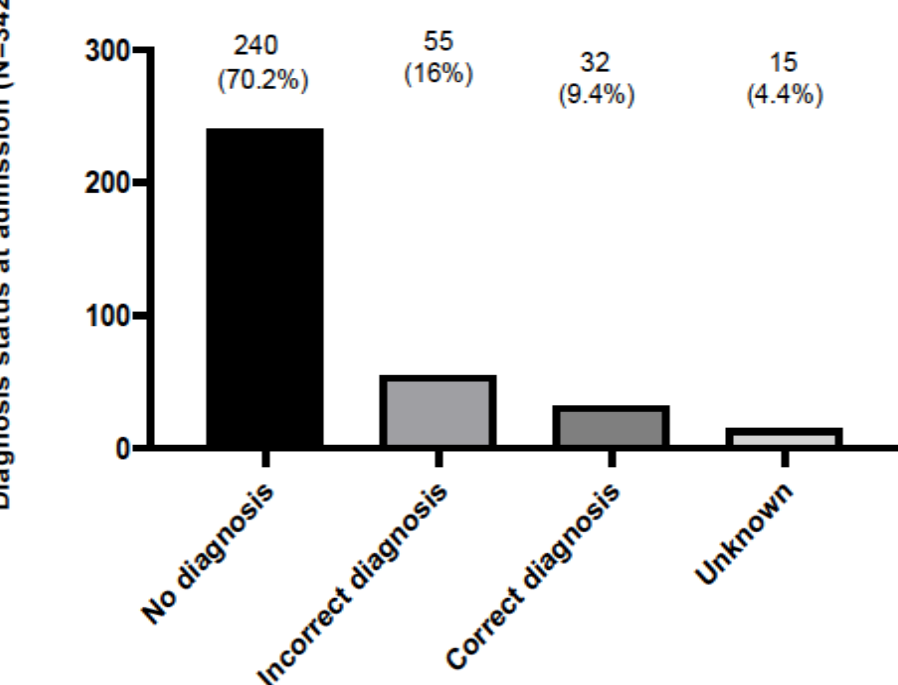
Figure 3. The frequency of patient admissions to the 2nd Department of Neurology, AHEPA Uni- versity Hospital of Thessaloniki and the resulting diagnosis: patients were either undiagnosed (no diagnosis), had received a wrong diagnosis (incorrect diagnosis) or were previously diagnosed correctly (correct diagnosis). Unknown means lacking data.